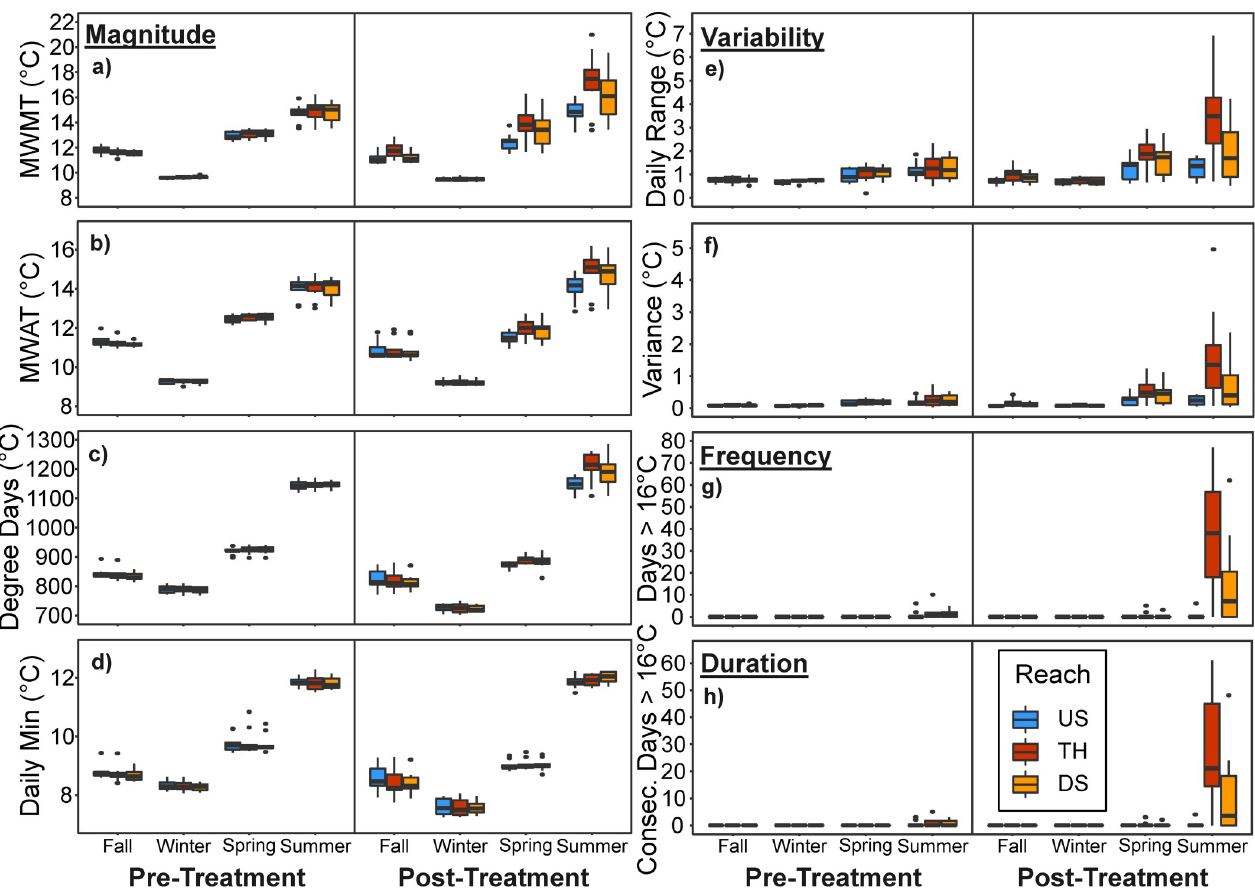
Fig 3. Stream thermal regime responses to riparian thinning. Seasonal patterns in stream temperature in upstream reference (US), thinned (TH), and downstream (DS) reaches during pre-treatment (2016) and post-treatment (2018) water years in northern California second-growth redwood forests. Boxplots show the distribution of responses across all sites (n = 10) for selected stream thermal regime descriptors including: magnitude (a-d), variability (e-f), frequency (g), and duration (h). Stream temperature responses were summarized for each seasonal window: Fall (October-December), Winter (January- March), Spring (April-June), and Summer